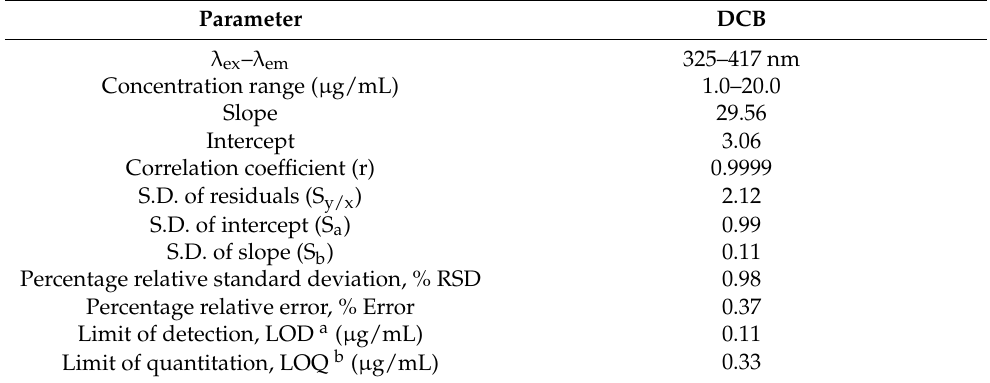
Table 1. Validation data for the determination of DCB by the proposed spectrofluorimetric